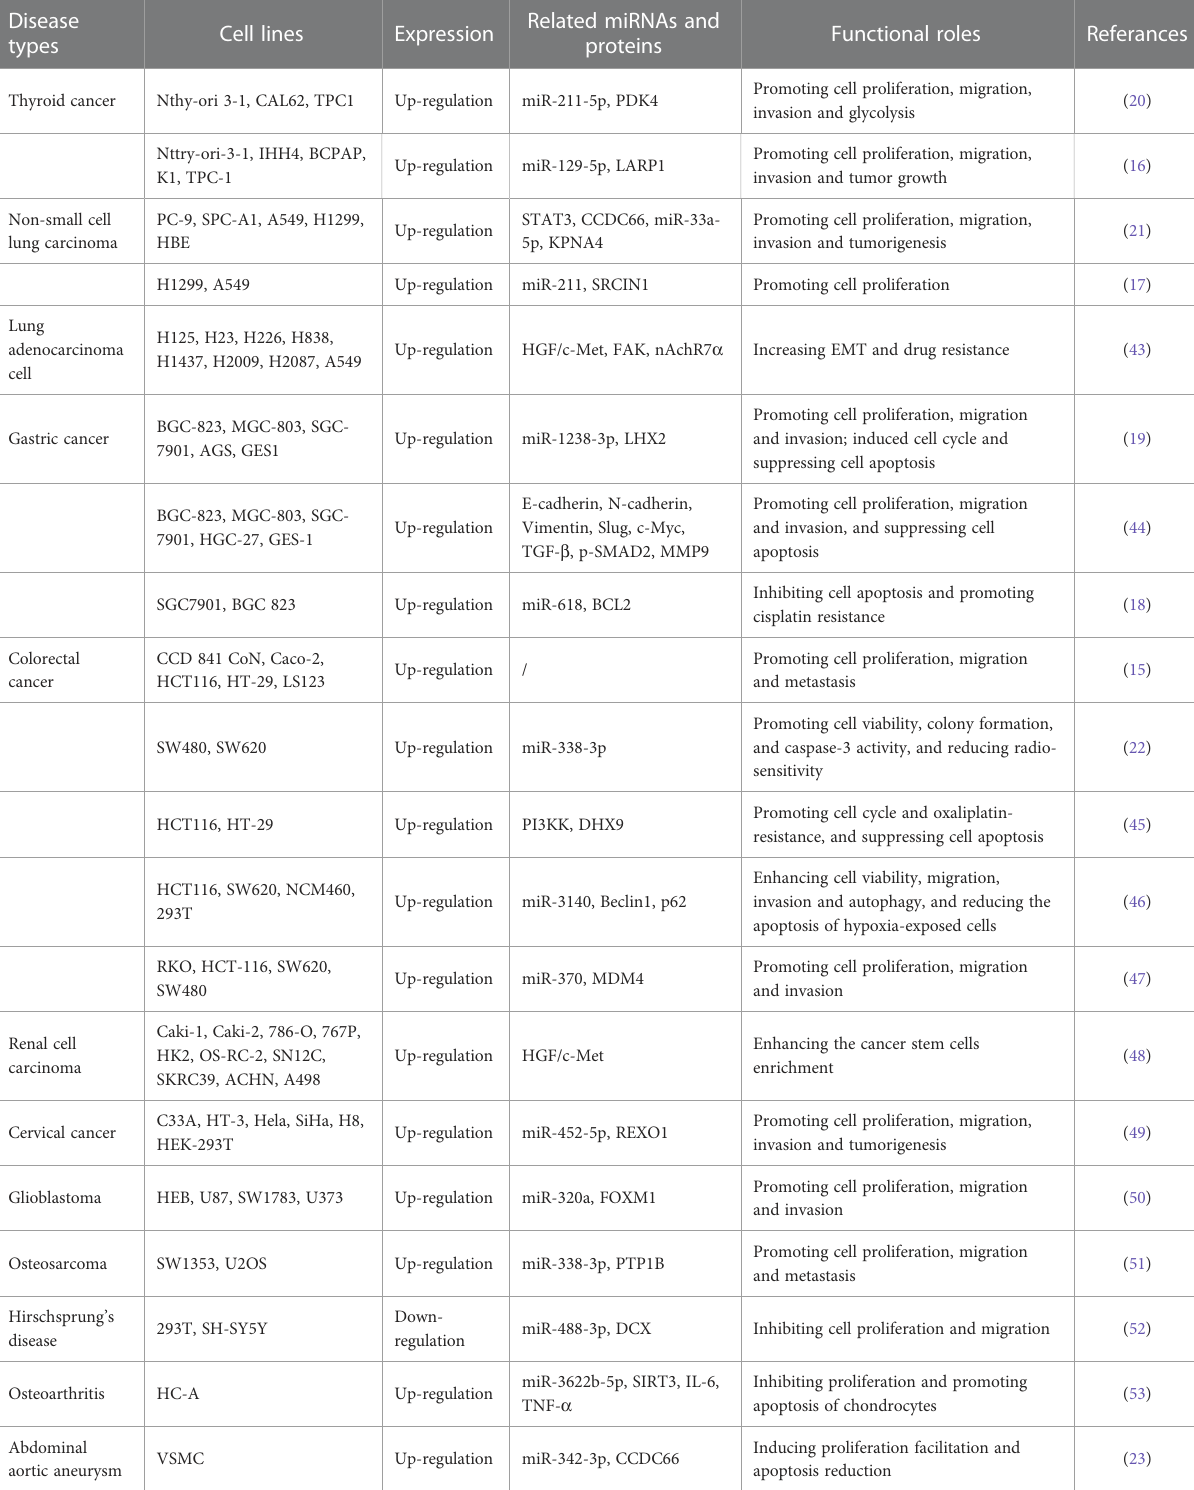
TABLE 1 Expression regulation and roles of circCCDC66 in various diseases including malignant tumors.